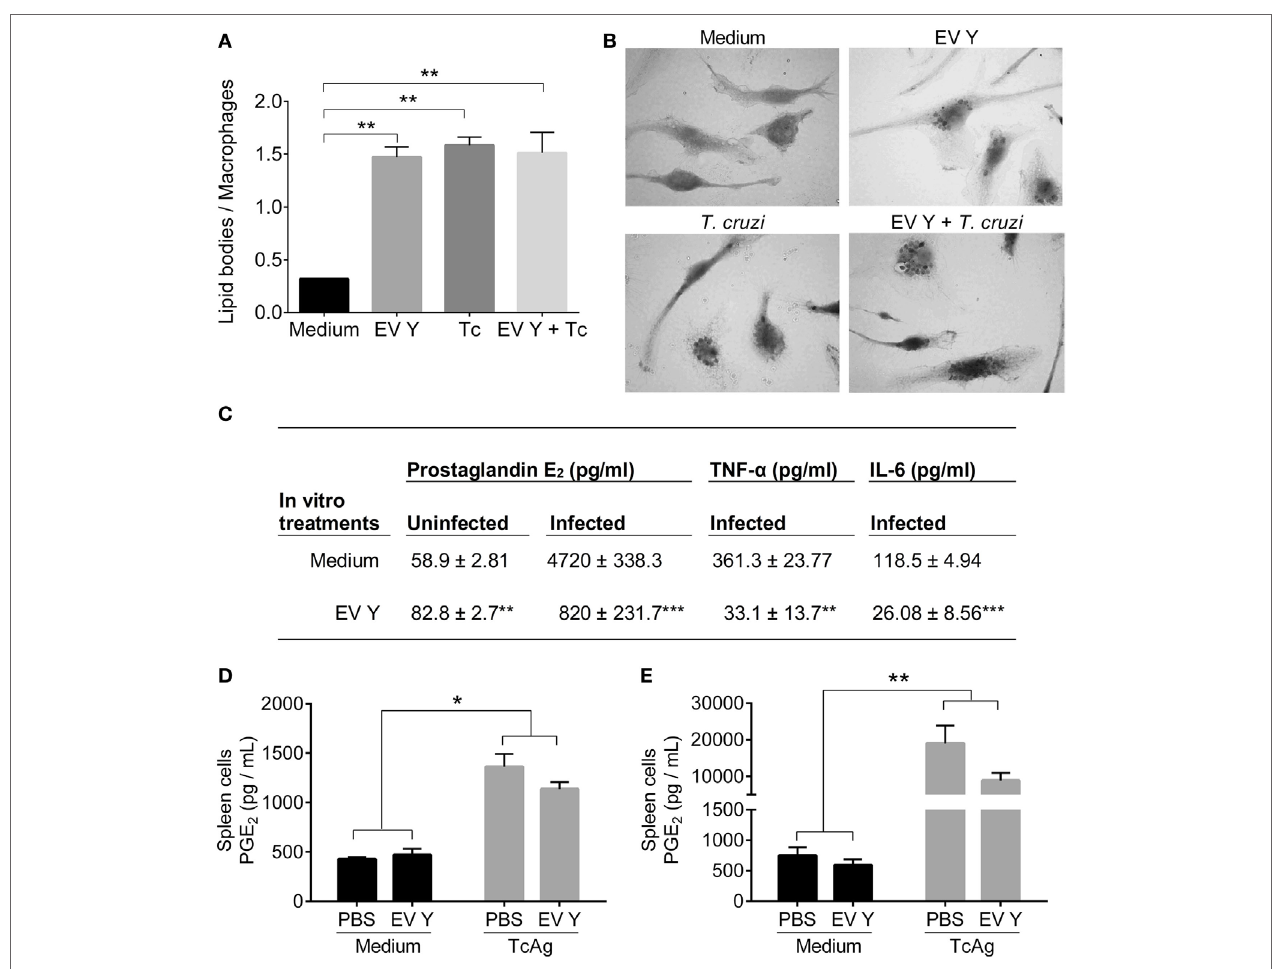
FigUre 7 | Trypanosoma cruzi extracellular vesicles (EVs) induce lipid body formation and prostaglandin E 2 (PGE 2 ) production by macrophages ( in vitro ) but not by spleen cells ( ex vivo ). Bone marrow-derived macrophages were incubated for 24 h with EVs derived from T. cruzi Y (EV Y) (i.p.). The cells were washed and infected with trypomastigote forms of T. cruzi (5 parasites per macrophage). After 24 h, non-internalized parasites were removed. (a) The cells were stained with osmium tetroxide and analyzed by light microscopy. The results are expressed as the mean ± standard error from each group in 250 cells counted in triplicate analysis in an experiment representative of two similar experiments. (B) Representative pictures of macrophage staining with osmium tetroxide at 1,000 × magnification of uninfected cells (without and with EV Y-upper panel) and infected cells in both groups (control and EV Y- bottom panel). The lipid bodies are visible as black markers inside the macrophages. (c) PGE 2 was quantified by ELISA, and cytokines (TNF- α and IL-6) were quantified by CBA in the supernatant culture of macrophages (uninfected and infected cells) after 24 h of infection. The results are expressed from two experiments. C57BL/6 mice were inoculated with EV Y (i.p.) and infected with T. cruzi by the same route 1 week later. Infected, uninfected, and PBS-inoculated mice were used as controls. Spleens were harvested 12 days after T. cruzi infection. The cells were cultured with medium or T. cruzi antigen (TcAg) for 8 h. (D,e) PGE 2 was quantified by ELISA in the supernatants of cultured spleen cells from uninfected and infected mice. The results are expressed as the mean ± standard error from four mice per group in one experiment. * P < 0.05; ** P < 0.01 significantly different (one-way ANOVA with Tukey’s post-test)—GraphPad